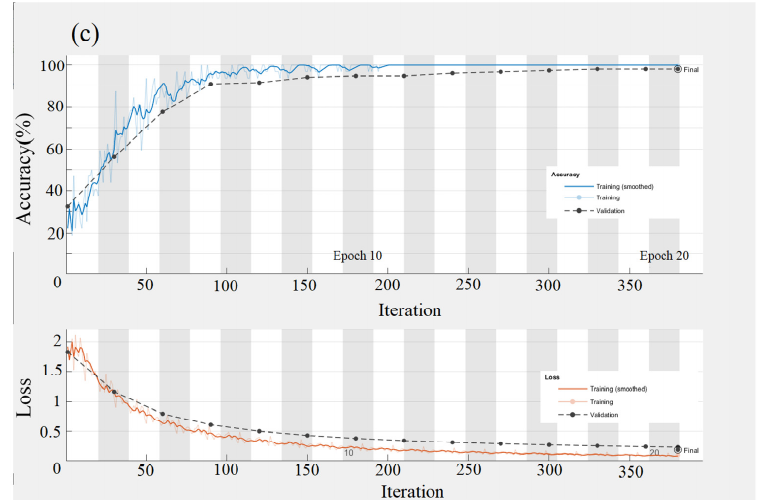
Figure 12. Accuracy and loss training map of original data set—( a ) Vgg16, ( b ) GoogLeNet ( c ) Resnet50.